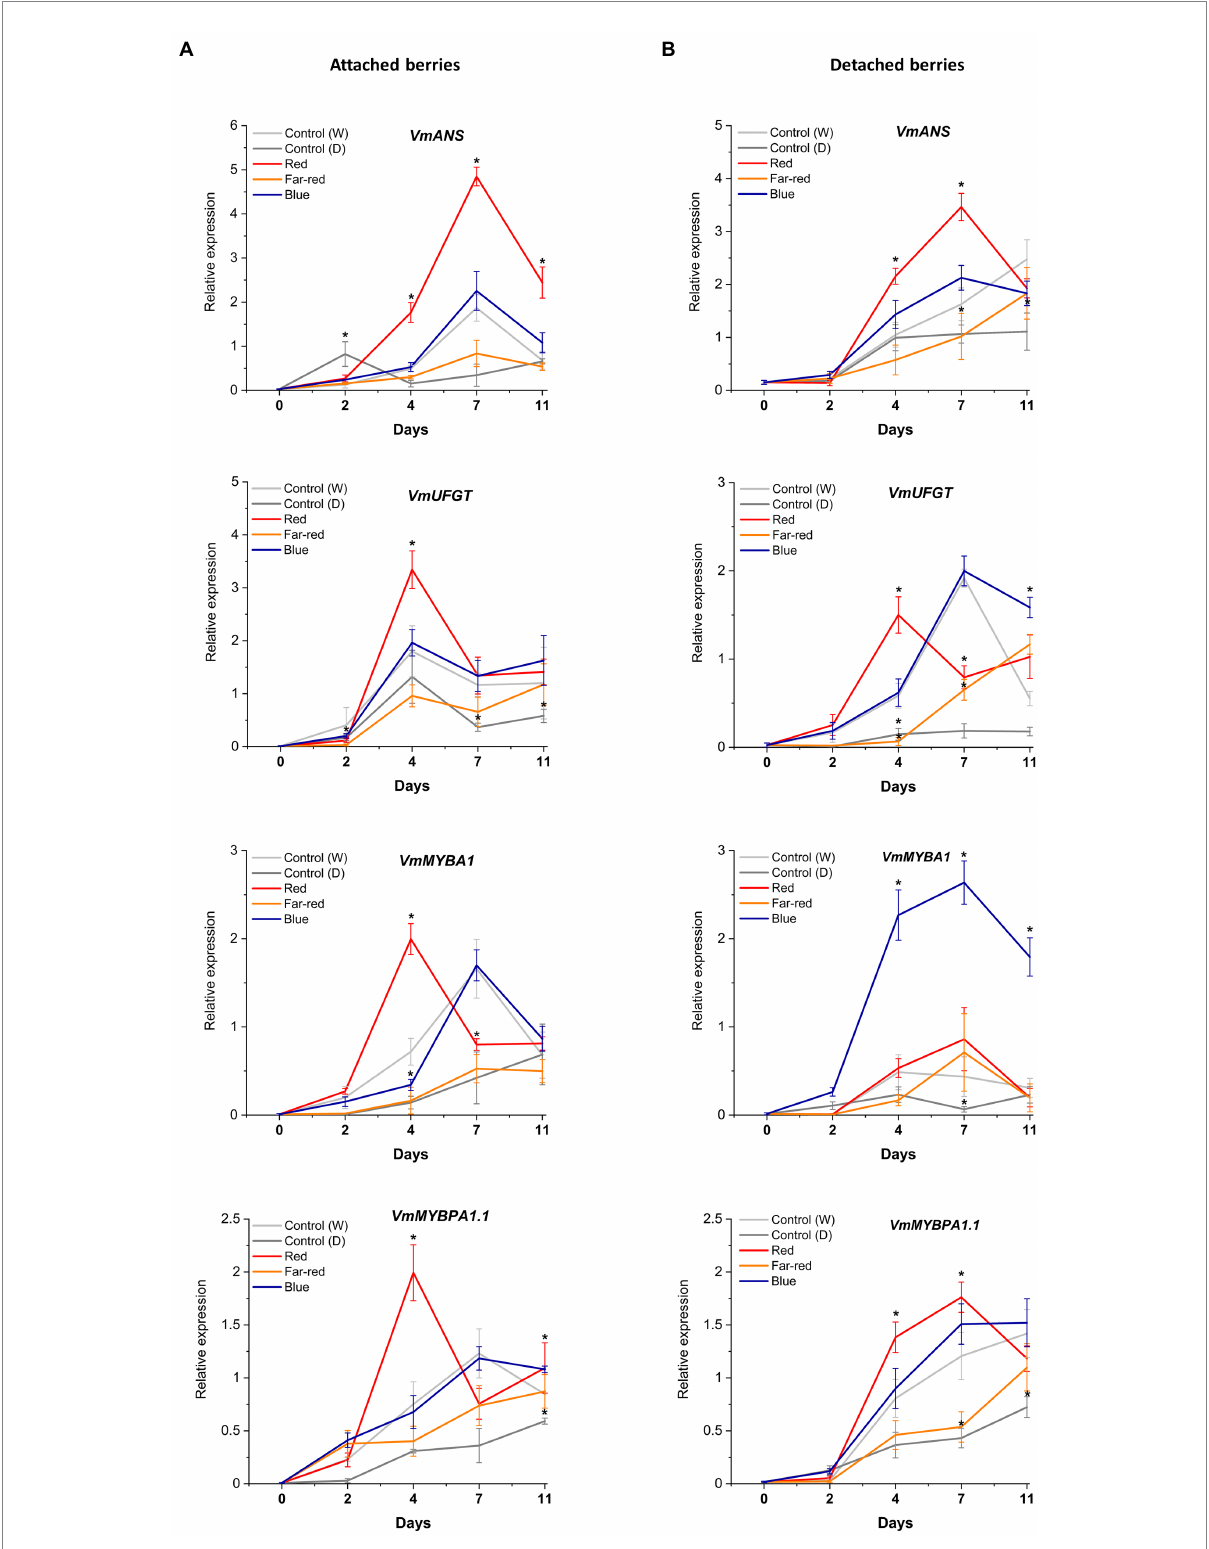
FIGURE 6 Effect of light spectral treatments on gene expression of late flavonoid biosynthetic genes ( VmANS and VmUFGT ) and key regulatory genes ( VmMYBA1 , VmMYBPA1.1 ) in attached berries (A) and in detached berries (B) . The expression levels were normalized to the housekeeping gene VmGAPDH or actin . Expressed in average of three biological replicates ±SE and significant differences between control and light treatments were analyzed by comparison of means using Student’s t -test (indicated in asterisks*) with value of p ≤